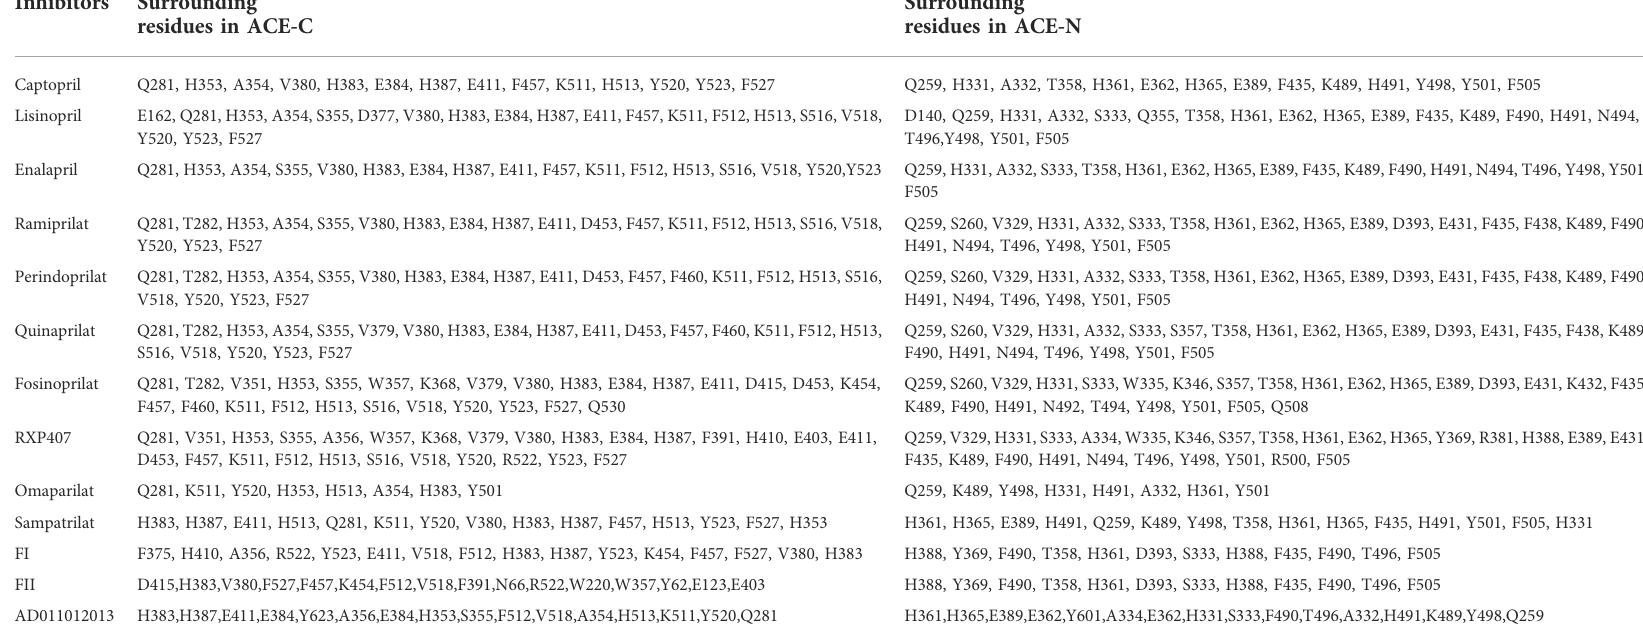
TABLE 1 ACE inhibitors and